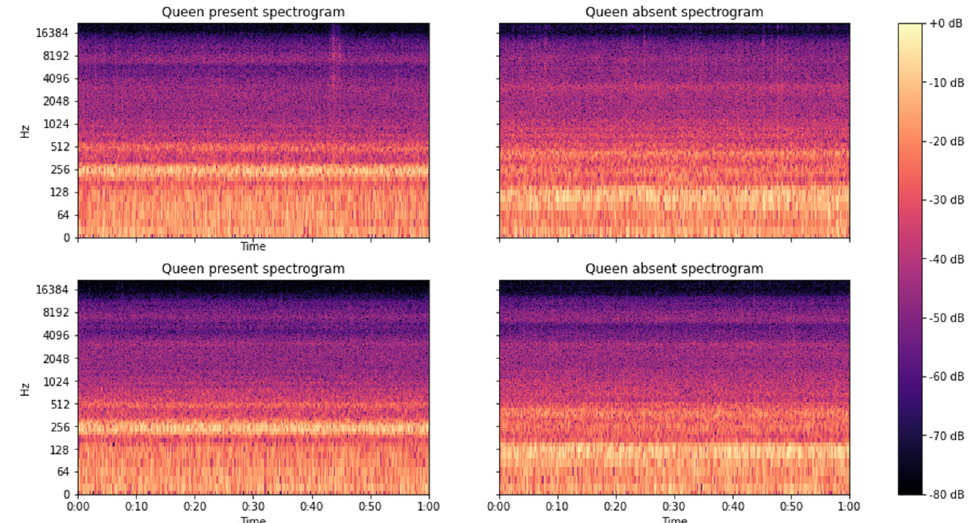
Figure 11. Example Acoustic Spectrograms for Queen Present ( left ) and “Queen Absent ( right ) hives. The brighter/lighter colours indicate more power in the signal in that frequency band. The Queen Present examples show a strong band centred around 250 Hz not observed in the Queen Absent ones, and whilst both sets show a band of moderate power around 500 Hz, the centre frequency of this band appears to be slightly higher for the Queen Present examples than for the Queen Absent ones.